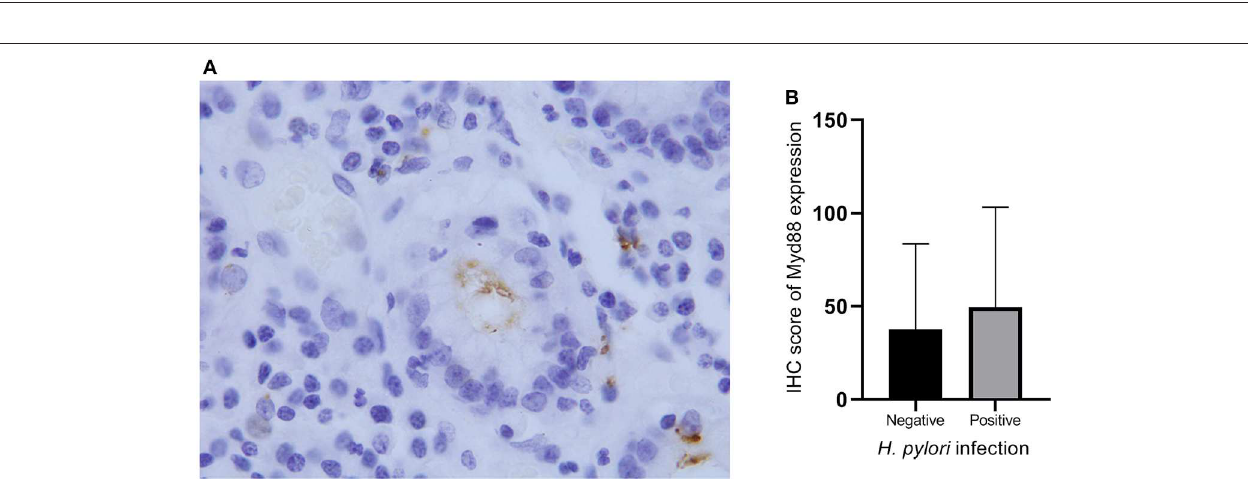
FIGURE 2 | Representative IHC staining for MyD88 (A) and NF- κ B p50/105 (B) in the same gastric cardia cancer tissue.